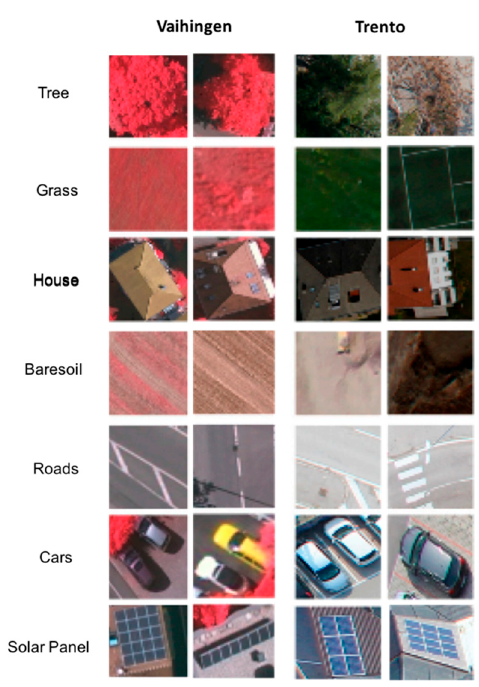
Figure 5. Example of samples from cross-scene dataset 2 composed of extremely high resolution (EHR) images.